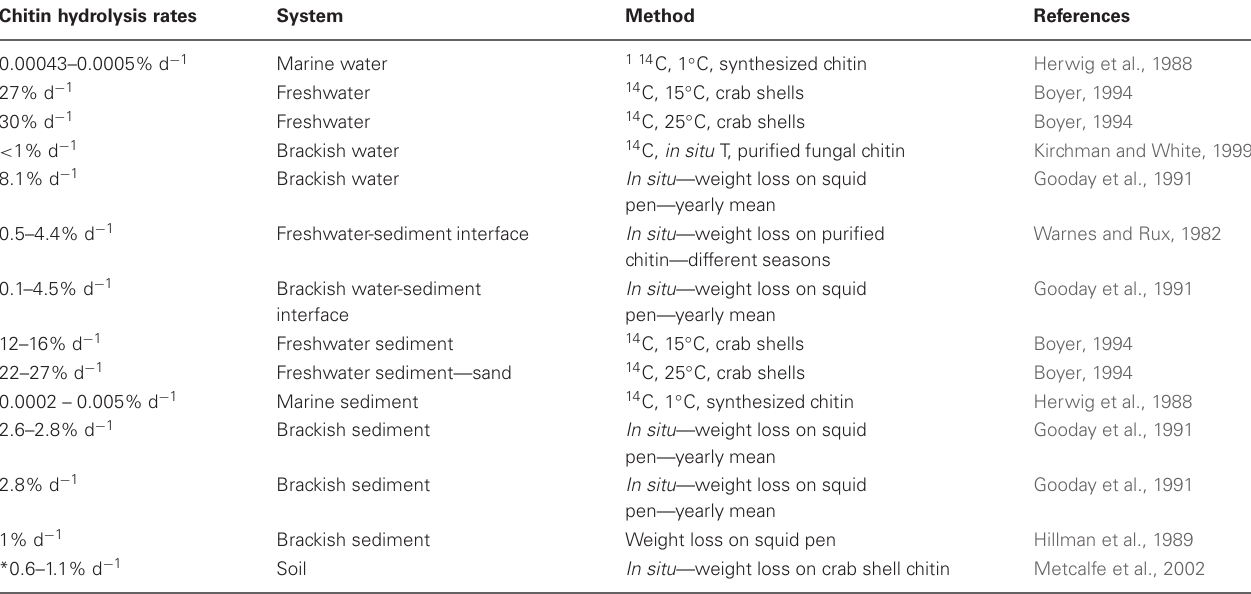
Table 3 | Chitin hydrolysis rates measured in natural habitats (values from experimental manipulations measured along with controls from natural habitats were excluded from the